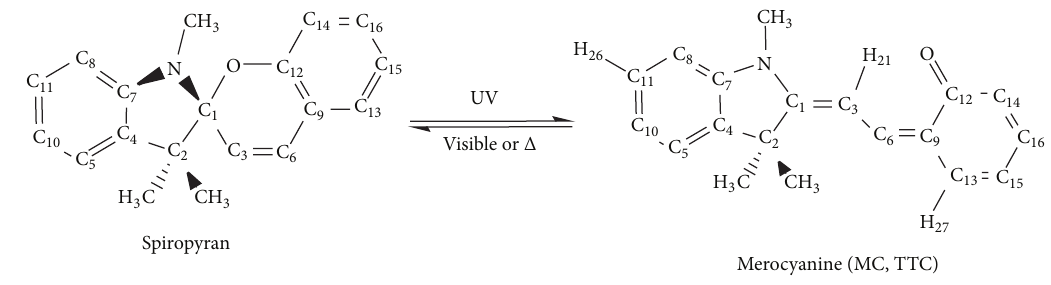
Scheme 1: The scheme of reversible reaction between SP and MC. Table 1: Key geometry parameters for the ground states of cis- and trans-SP forms as well as the corresponding mode compounds (bond distance in angstroms and dihedral angles in